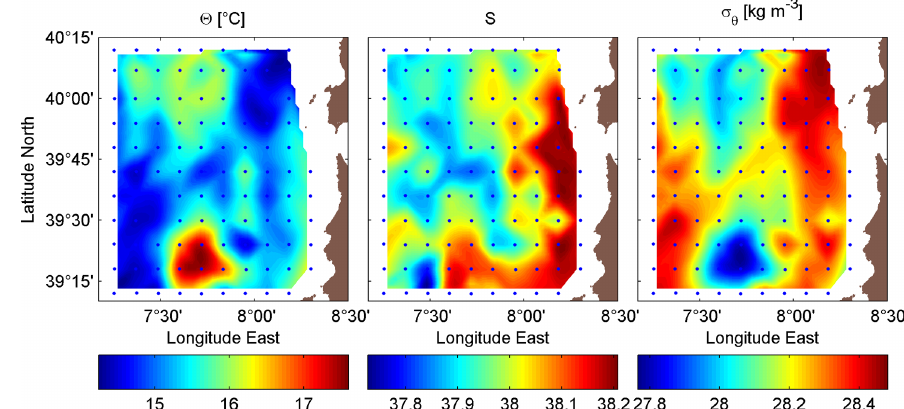
Figure 7. Potential temperature ( (cid:50)) , salinity ( S ), and potential density anomaly ( σ (cid:50) ) distribution at the pressure level of 50dbar based on CTD casts (blue dots) obtained by Planet from 8 to 18 June.